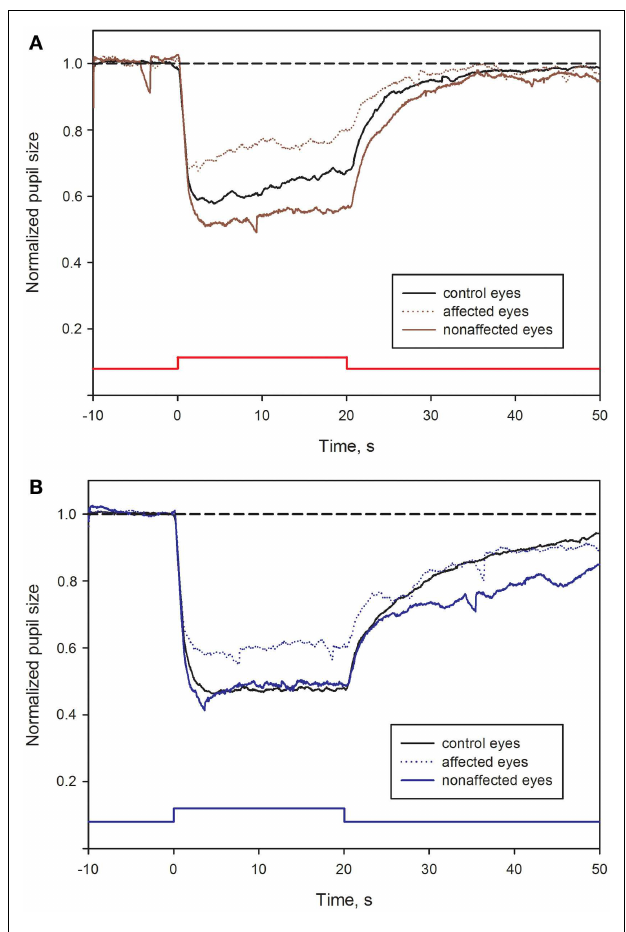
FIGURE 2 | Pupil responses in NAION-affected and fellow non-affected eyes, and in healthy control eyes . (A) : pupil response curves for stimulation with red light. (B) : pupil response curves for stimulation with blue light.The broken line represents the reference line of baseline pupil size equal to 1.0.The vertical bar at the bottom indicates light stimulus onset: time 0 is light onset, time 20 is light offset. For parameter definitions, Section “Materials and Methods” and Figure 1 . In all NAION patients, most of the pupil response parameters to 300cd/m 2 red (A) or blue light (B) were significantly reduced in the affected eyes (stippled curve), compared with the non-affected eyes (solid curve).When comparing the affected eyes with the healthy control eyes (black curve), the pupil responses during light exposure (maximal contraction amplitudes) were reduced in the affected eyes, reaching significance only at blue light conditions ( p < 0.05, B ). No significant difference was found for the post-illumination response . In contrast, the blue light late post-illumination response in the non-affected eyes was significantly increased ( p < 0.05, B ), compared with the healthy